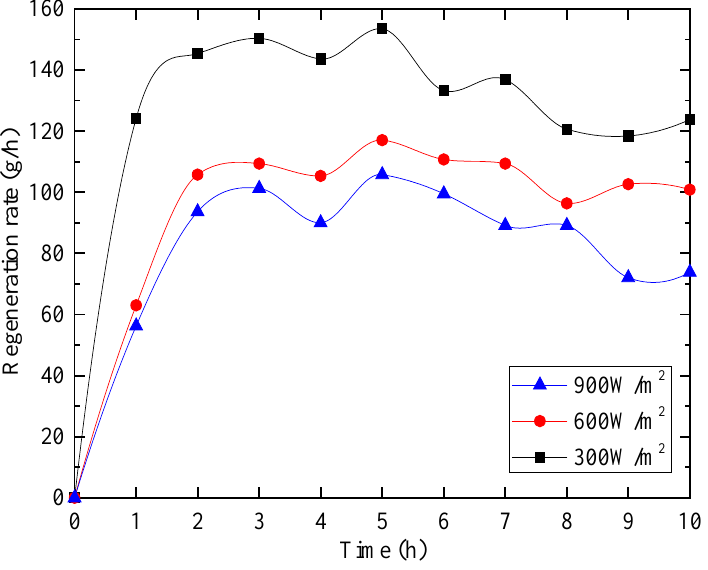
Figure 10. The variation of the regeneration rate of the solid desiccant modules with time.